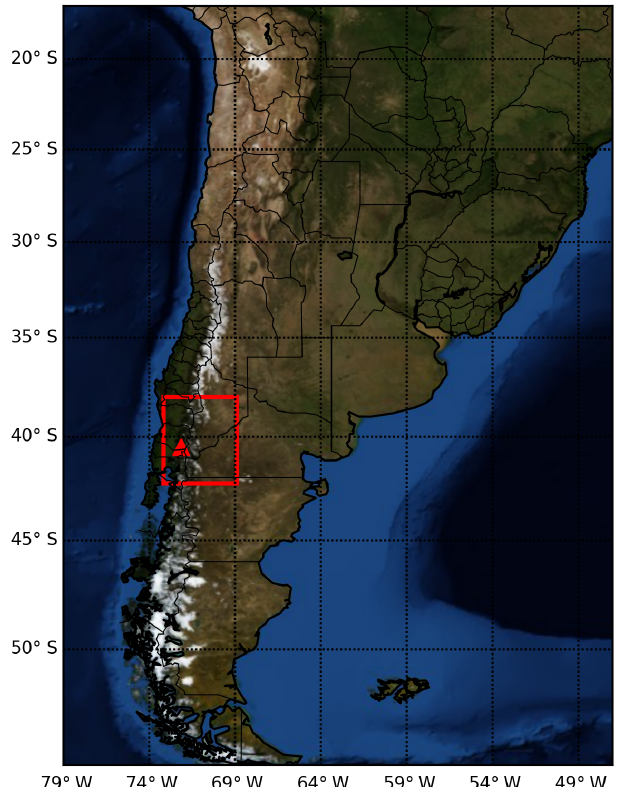
Figure 3. Domain used in the ETKF–FALL3D sensitivity tests (red square).